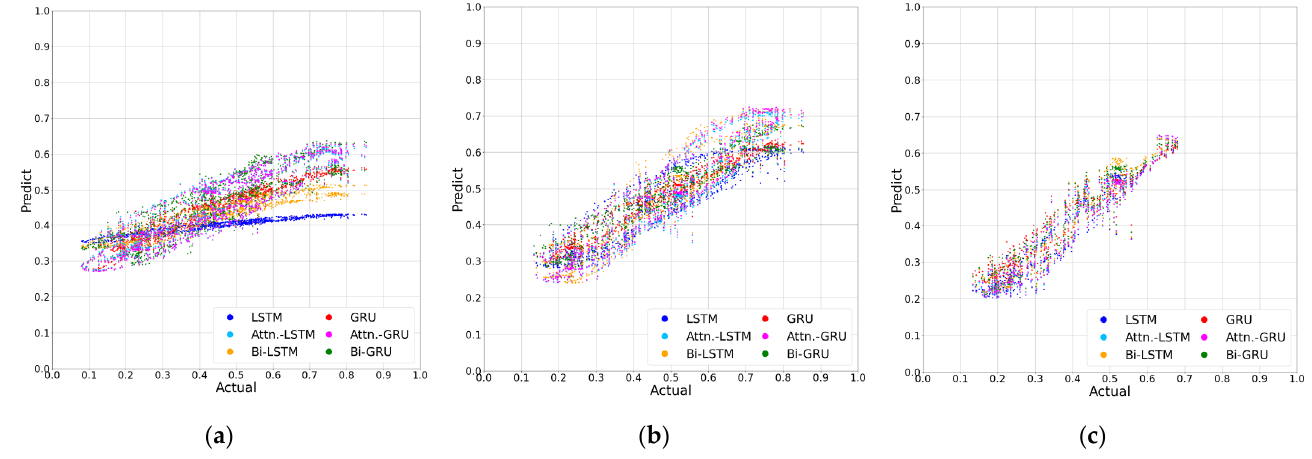
Figure 12. Scatter plots of abnormal vibrations: ( a ) 40%, ( b ) 60%, ( c ) 80% segment of training data .